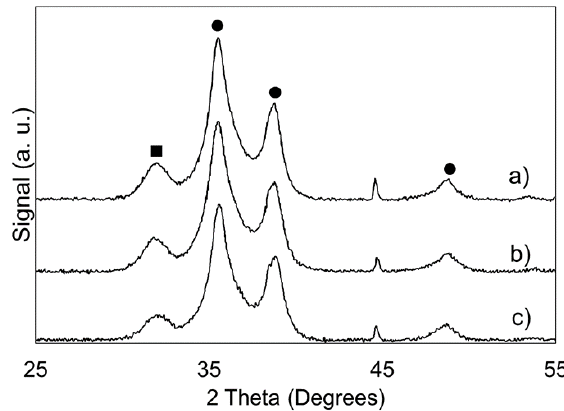
Figure 8. X-ray di ff raction (XRD) patterns for Ni / Cu / ZnO / Al 2 O 3 -OA with di ff erent amounts of Ni Figure 8. X-ray diffraction (XRD) patterns for Ni/Cu/ZnO/Al 2 O 3 -OA with different amounts of Ni loading (molar). ( a ) Ni / Cu / Zn / Al (molar) = 5 / 32.5 / 32.5 / 30, ( b ) Ni / Cu / Zn / Al (molar) = 1 / 34.5 / 34.5 / 30, loading (molar). ( a ) Ni/Cu/Zn/Al (molar) = 5/32.5/32.5/30, ( b ) Ni/Cu/Zn/Al (molar) = 1/34.5/34.5/30, ( c ) ( c ) Cu / Zn / Al (molar) = 35 / 35 / 30. (cid:8) CuO, (cid:4) ZnO. All traces have been displaced for clarity. Cu/Zn/Al (molar) = 35/35/30. ● CuO, ■ ZnO. All traces have been displaced for clarity. Table 2. Some physicochemical properties of the Ni / Cu / ZnO / Al 2 O 3 -OA. Table 2. Some physicochemical properties of the Ni/Cu/ZnO/Al 2 O 3 -OA. Crystal Size of CuO